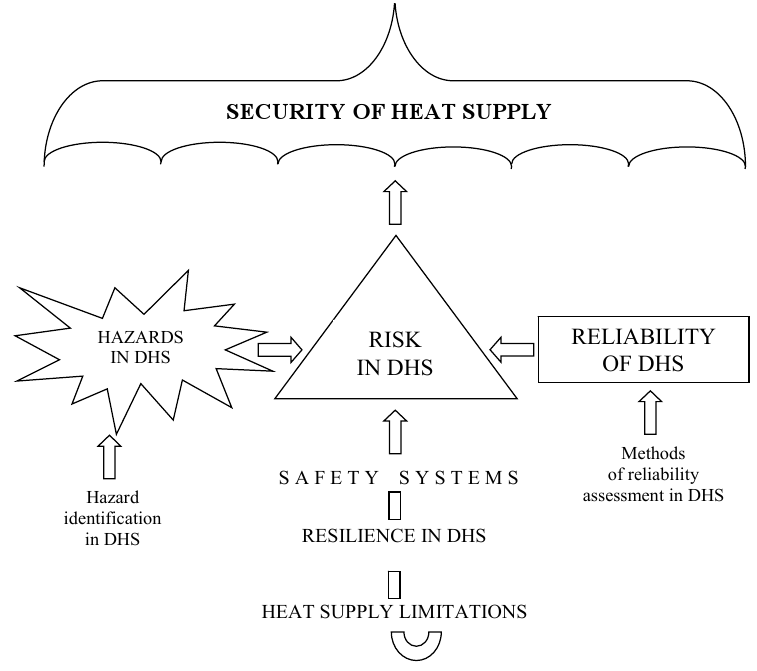
Figure 1. The concept of reliability, security and risk analysis in the district heating system (DHS).